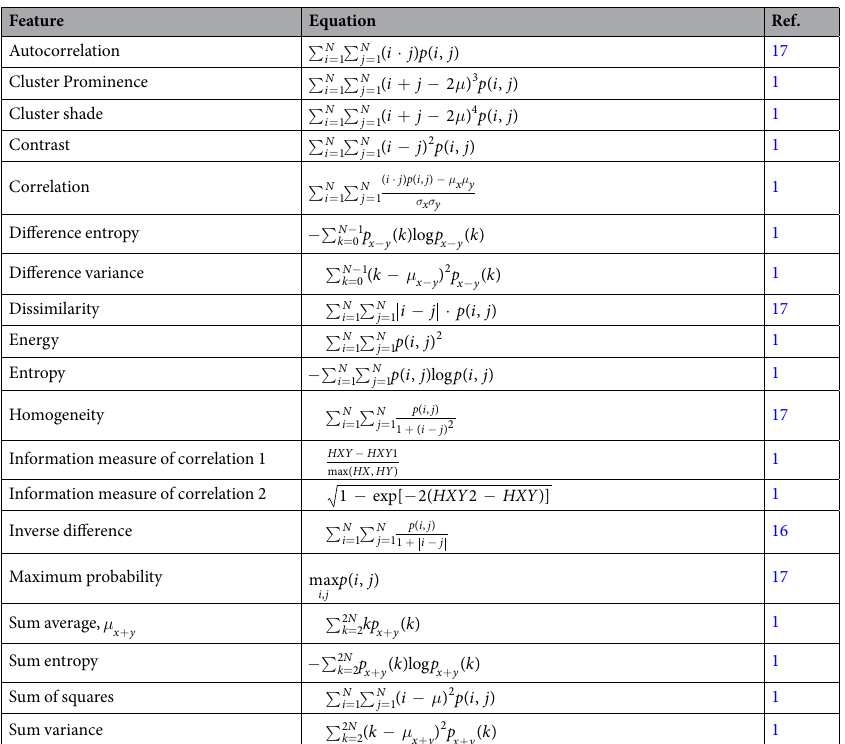
Table 3. Haralick texture features calculated from GLCMs. There was an error in the definition of Sum variance in Haralick et al . 1 , which has been